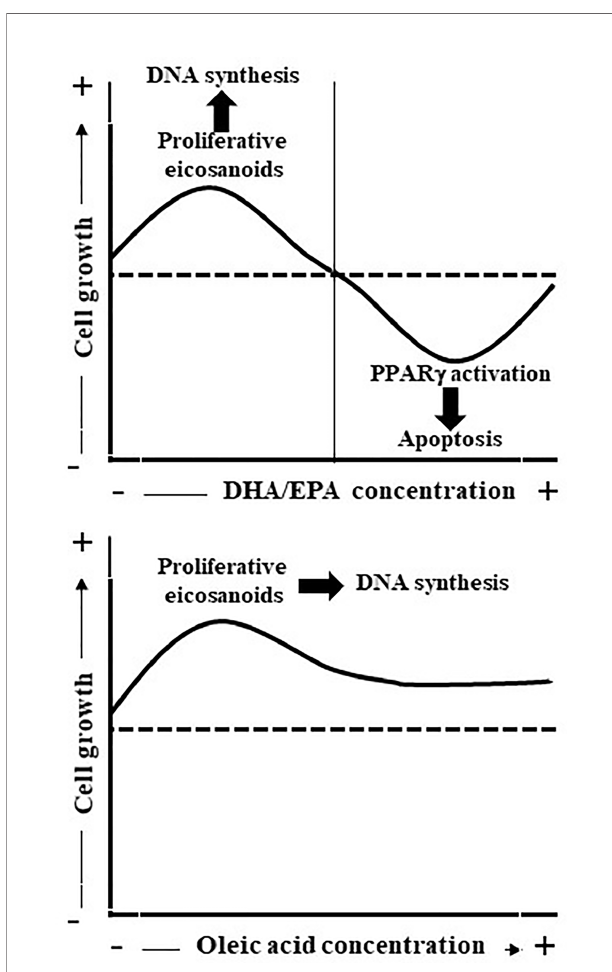
FIGURE 7 | Scheme represents the effect of oleic acid and EPA/DHA on Caco-2 cell growth and apoptosis. Oleic acid is mitogenic probably through LOX pathway metabolite synthesis whereas EPA/DHA present a dual effect on Caco-2 cell proliferation. Low EPA concentrations (up to 10 µM) induce Caco-2 cell growth as consequence, at least in part, of PGE 3 and 12-HEPE release whereas high EPA concentrations inhibit Caco-2 cell growth and induce apoptosis through binding to PPAR g